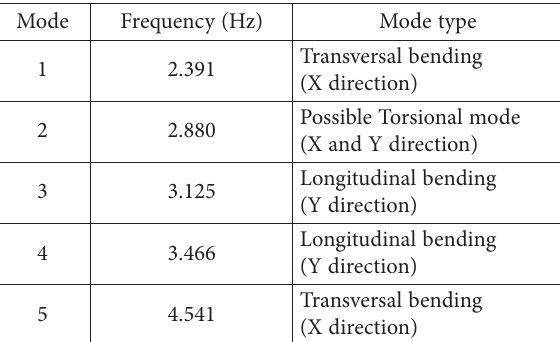
Table 2. Natural frequencies identified through ambient vibration testing of the Nossa Senhora das Dores Church Mode Mode type